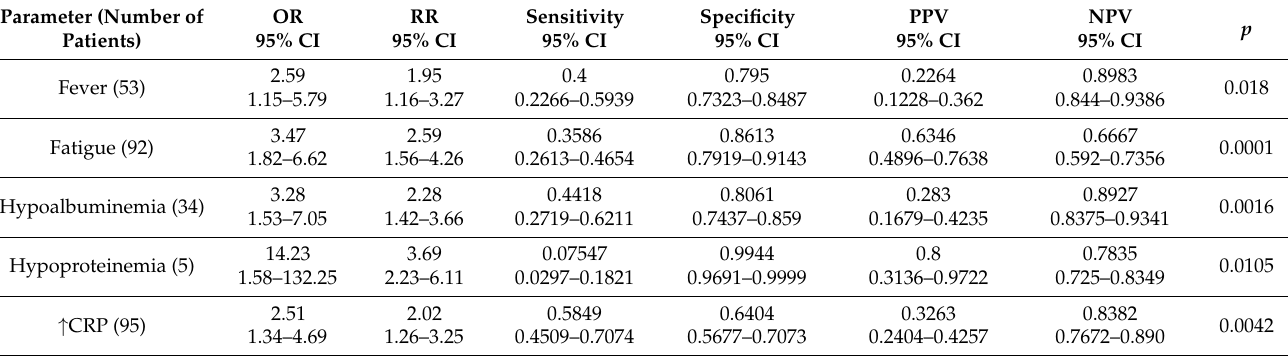
Table 7. IBD—predictors of Table 7. IBD- predictors of biologics.